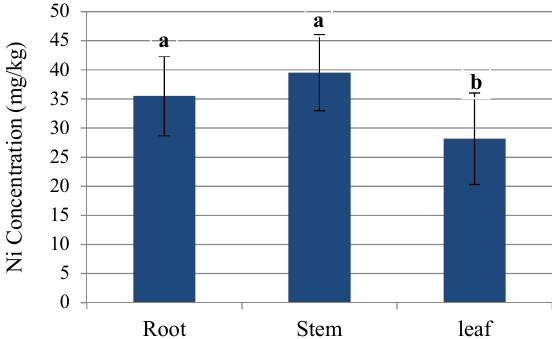
Fig. 4. Mean Ni Concentration in Treatment of 100 mg/kg